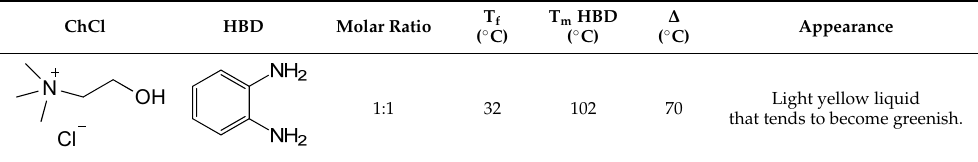
Table 4. Eutectic temperature (T f ) of the DES and melting point (T m *) of the pure HBD. ChCl